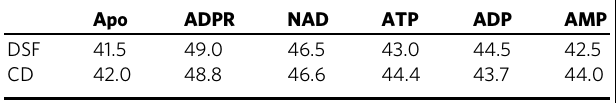
Table 1 Melting temperature of the MERS-CoV macro domain in apo form and in complex with various NAD metabolites determined by differential scanning fl uorometry (DSF) and circular dichroism (CD).